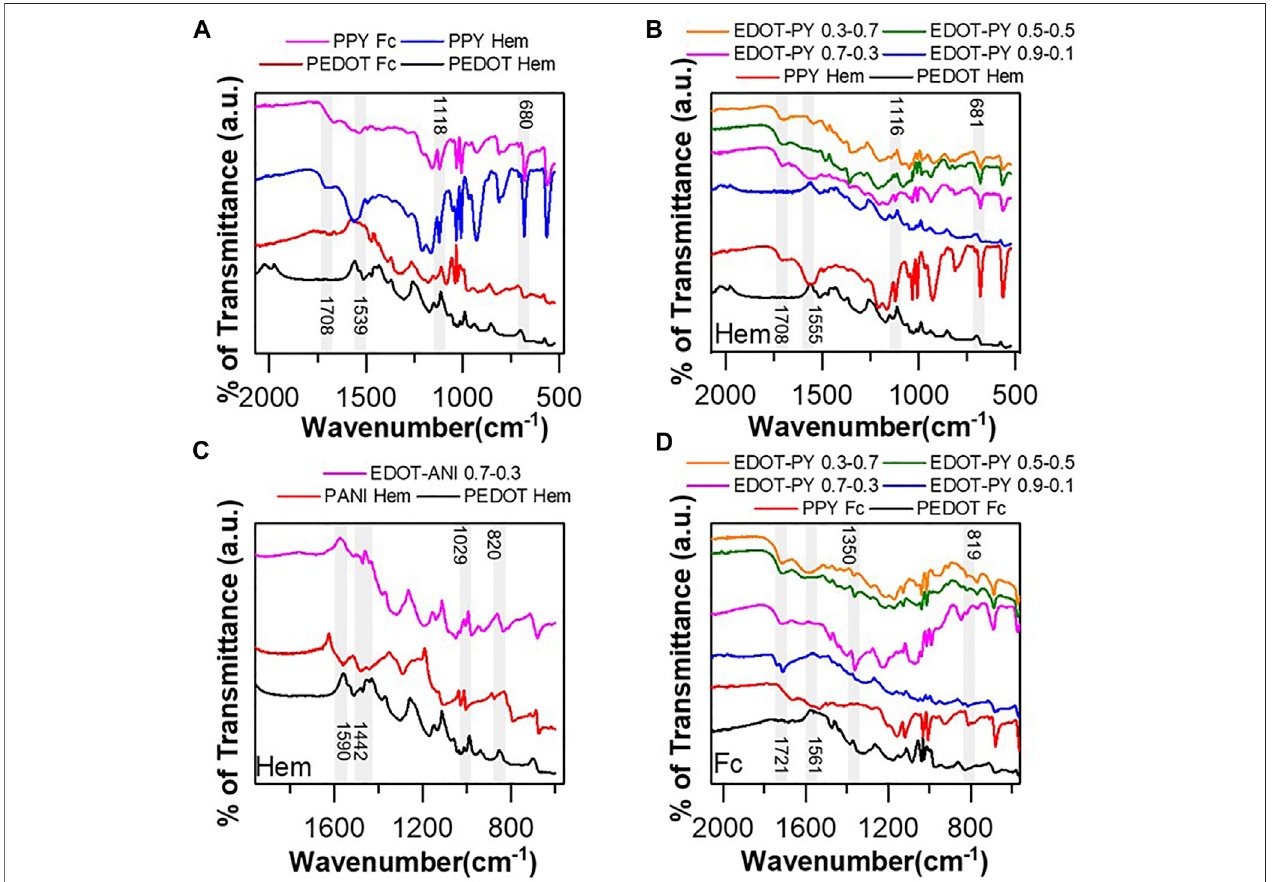
FIGURE 4 | (A) FTIR spectra of PEDOT and PPY synthesized biomimetically using ferrocene and hematin as catalysts, (B) FTIR spectra EDOT-PY copolymers Hematin-catalyzed Biomimetic synthesis, (C) FTIR spectra copolymers EDOT-ANI biomimetic synthesis catalyzed by Hematin, (D) FTIR spectra EDOT-PY copolymers Ferrocene-catalyzed biomimetic